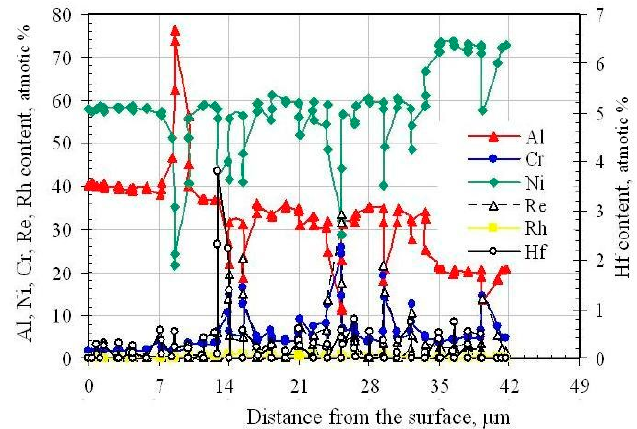
Figure 9. Elements’ distribution on the cross-section of the rhodium- and hafnium-modified aluminide coating.